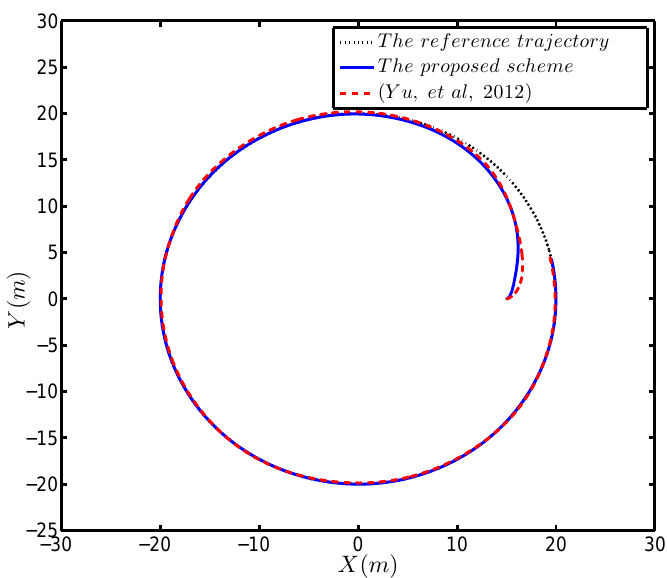
Figure 7. Comparison results of circle trajectory tracking.